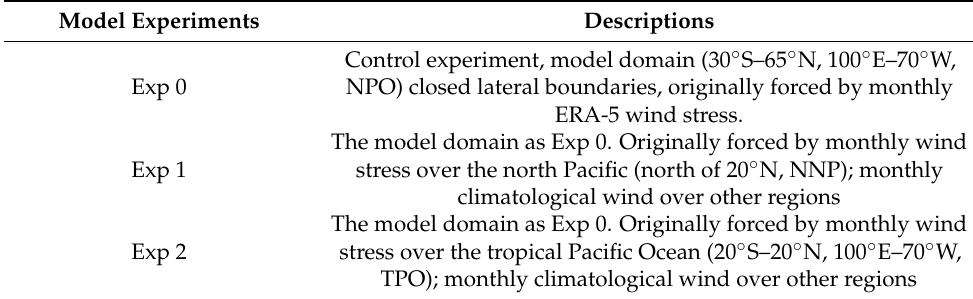
Table 1. Numerical experiments of the 1.5-layer reduced gravity model. Model